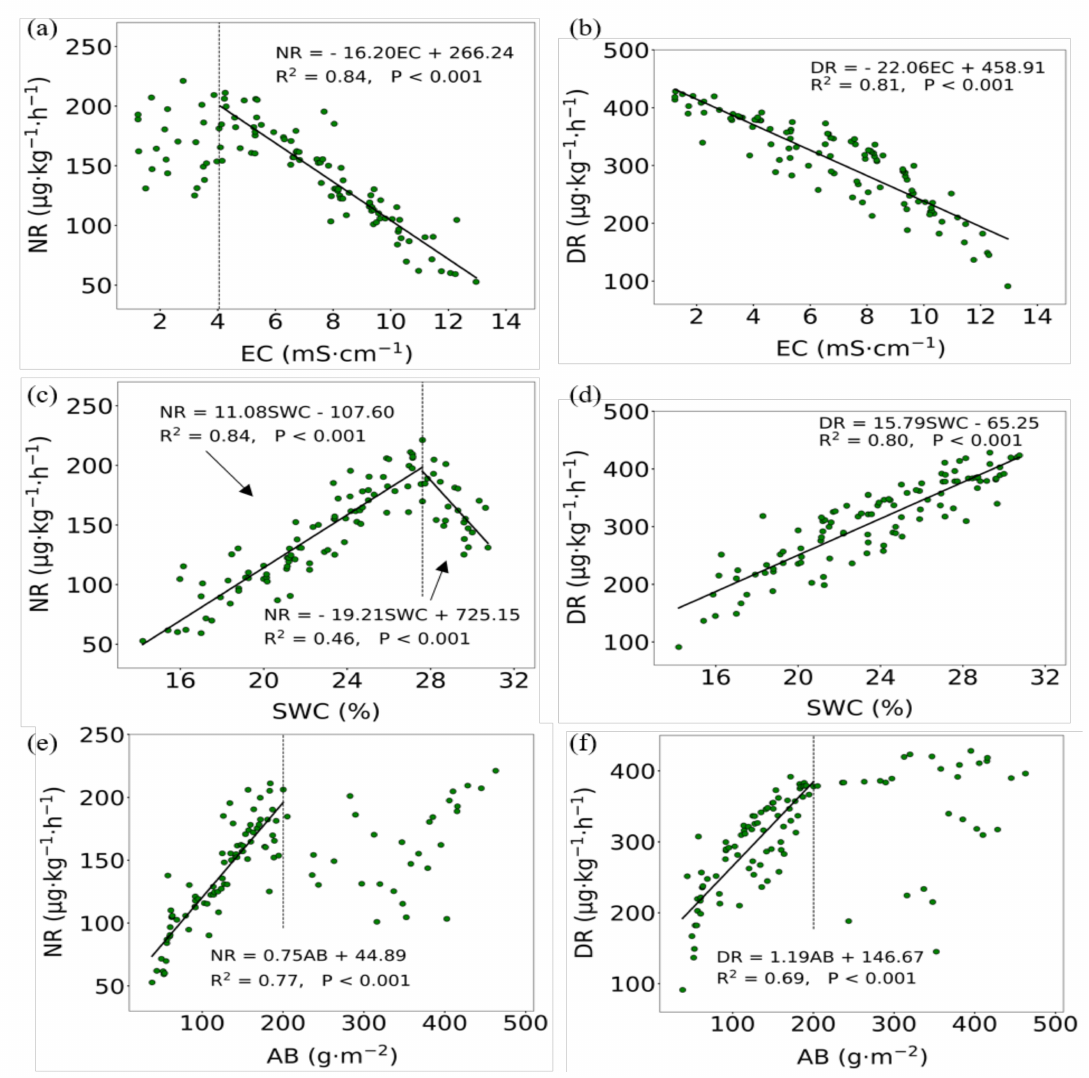
Figure 4. Relationships between soil nitrification rates (NR) and denitrification rates (DR) and the main controlling factors in the studied wetland ( a ) NR and soil electrical conductivity (EC), ( b ) DR and EC, ( c ) NR and soil water content (SWC), ( d ) DR and SWC, (e) NR and aboveground biomass (AB), and ( f ) DR and